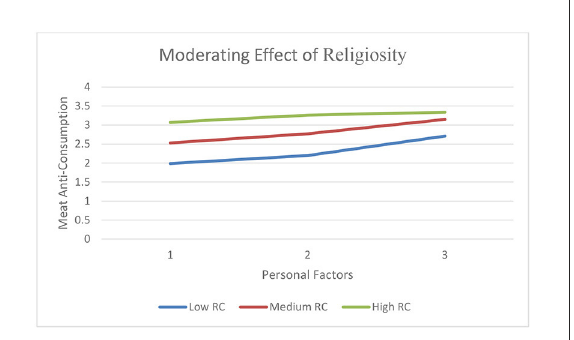
FIGURE2 A Plot of PF, Personal Factors; MAC, Meat Anti-consumption, vs. RC, Religious Connotations the Moderator with Meat.